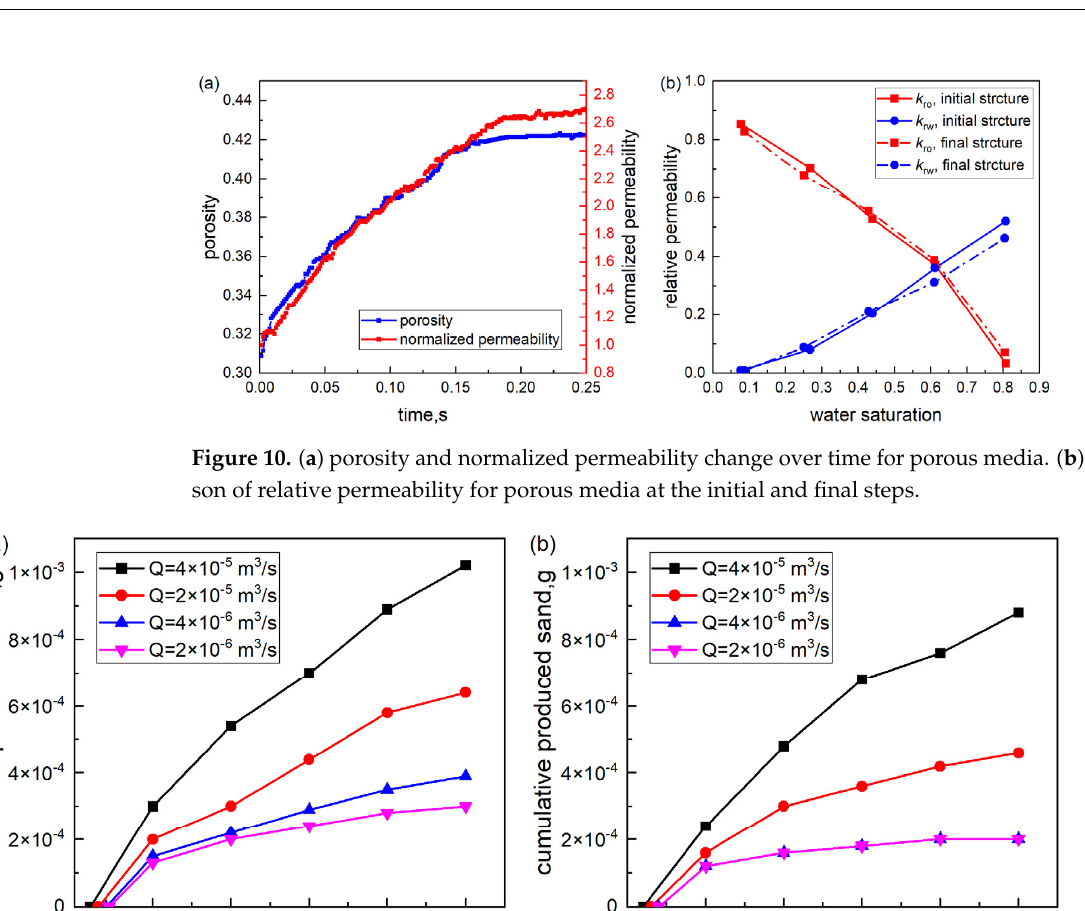
Figure 11. Cumulative weight of produced sand at different injection rates. ( a ) confining pressure equals 0.8 MPa ( b ) confining pressure equals 3 MPa.